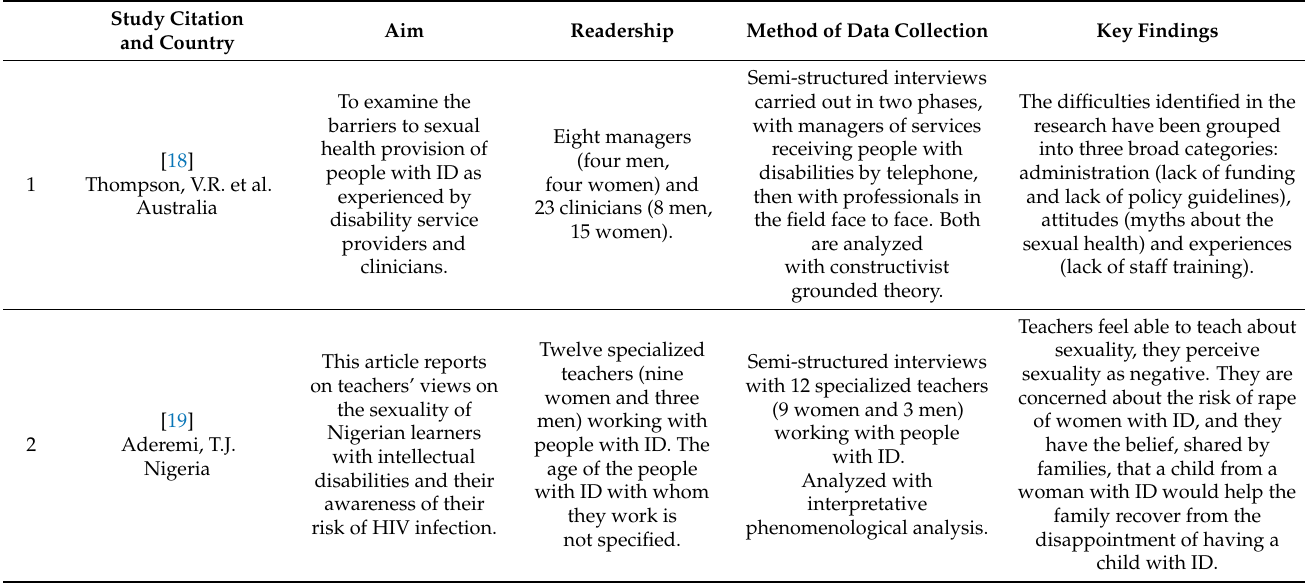
Table 1. Articles included in the systematic review on “representations of the sexuality of people with intellectual disabilities by professionals in specialized